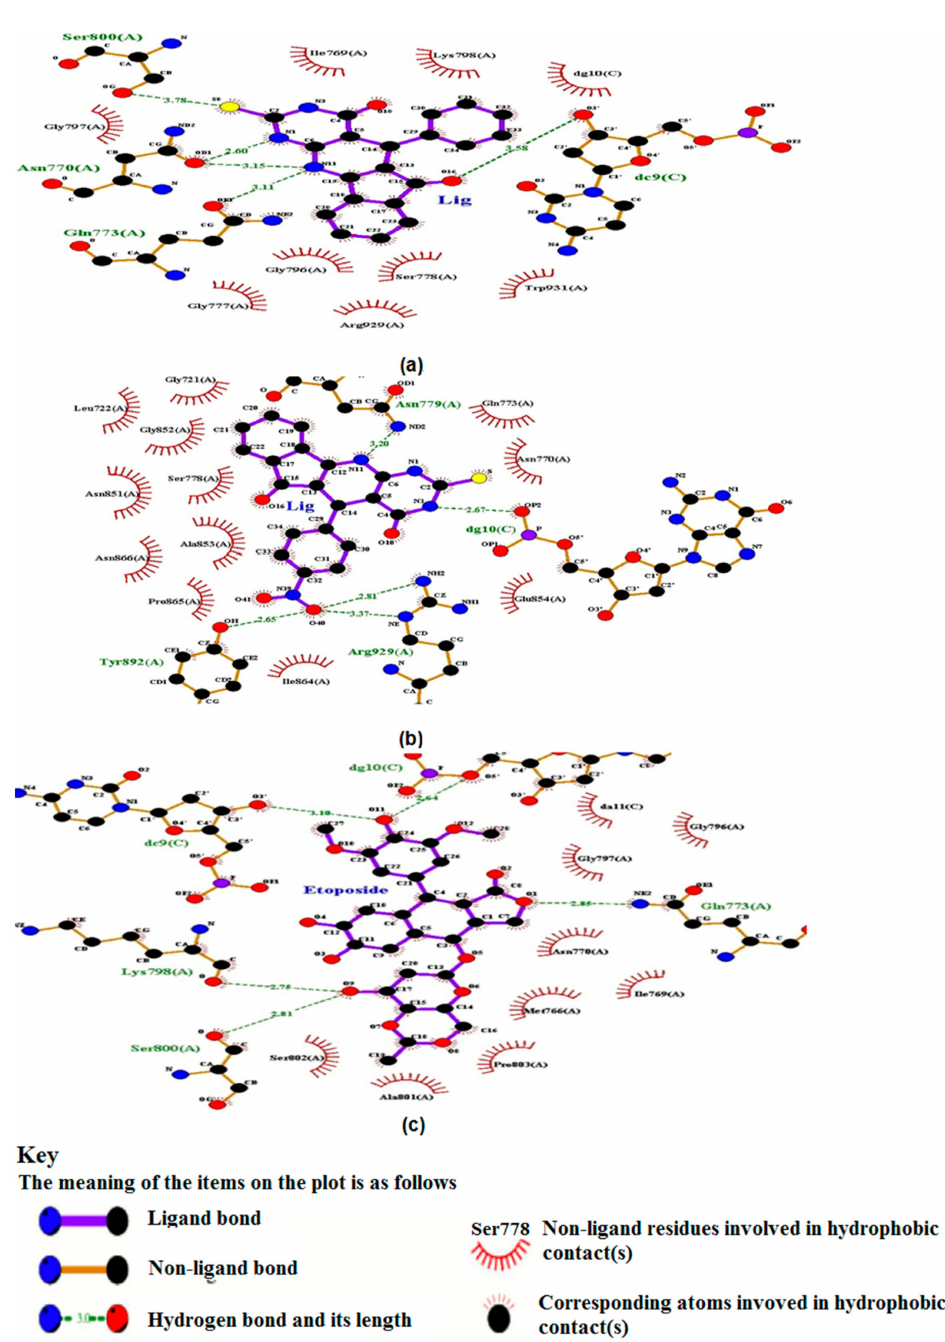
Figure 7. ( a – c ) Two-dimensional binding sites scheme of 2H, 6H and etoposide, respectively, with human DNA topoisomerase II α ,